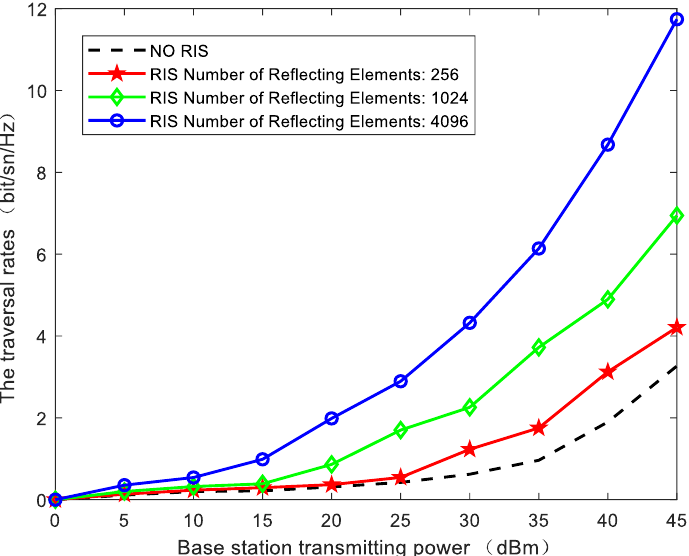
Figure 7. Traversal achievable rate assisted by different number of RIS reflection elements.